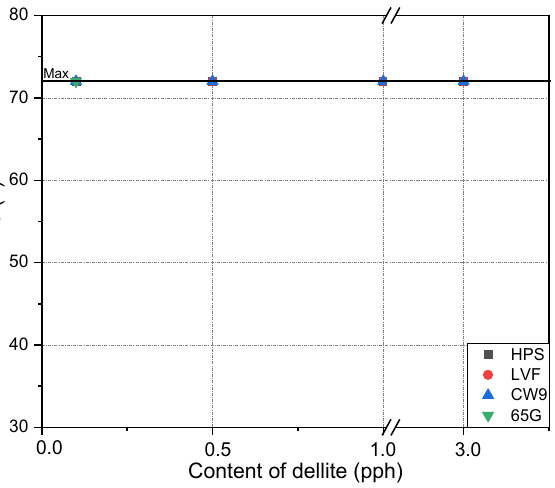
Figure 6. Effect of contents of dellite addition on the cohesion at 70 °C of silicone pressure-sensitive adhesives.